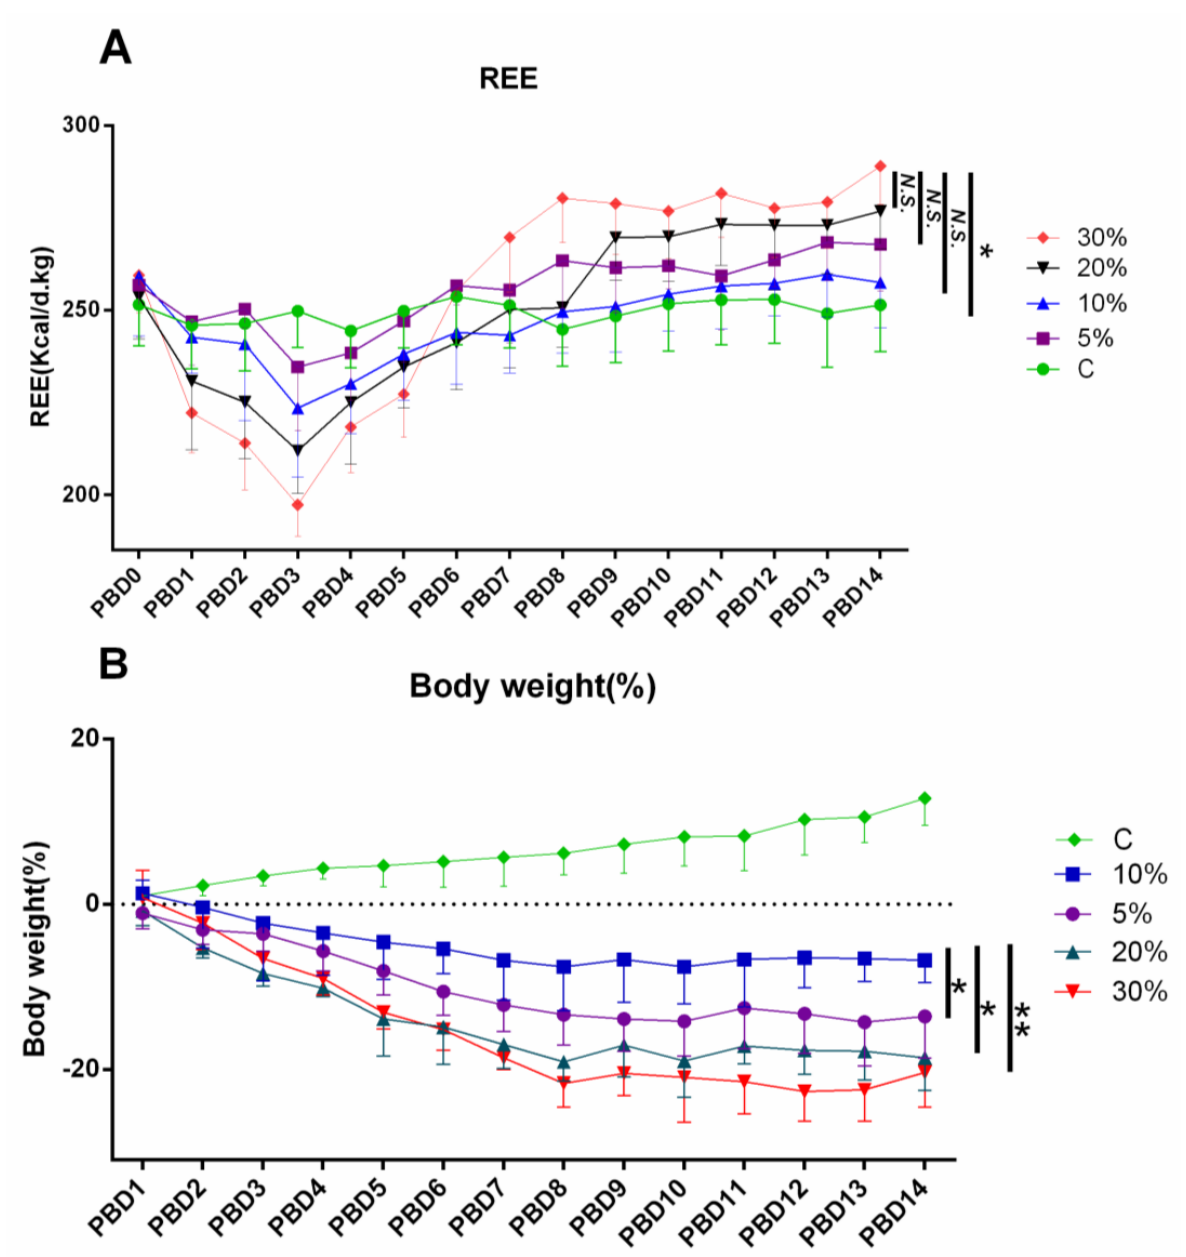
Figure 2. Effect of different carbohydrate − fat on REE and body weight 14 days after burn injury. REE (kcal/d/kg) of the 5%, 20% and 30% groups compared with the control group ( A ). Body weight loss of the 5%, 20% and 30% groups compared with the control group ( B ). n = 6 per group. * p < 0.05, ** p < 0.01; PBD: post − burn day.